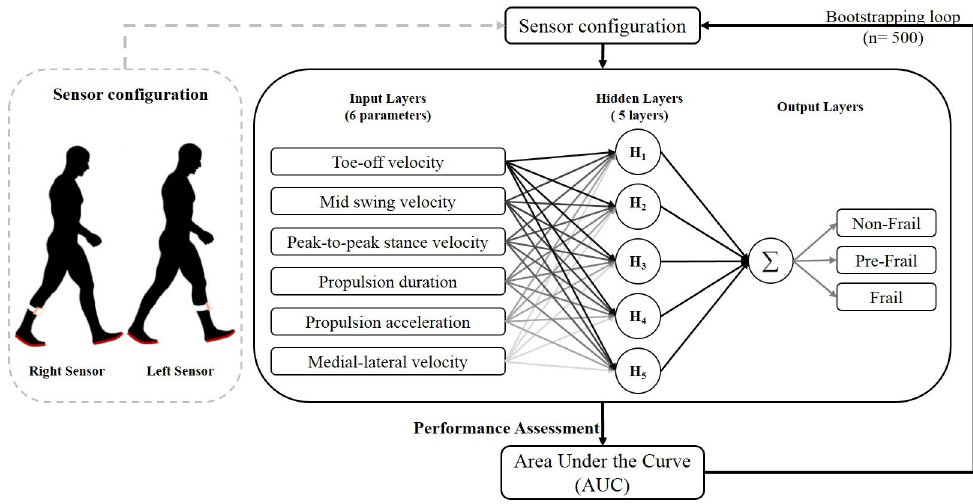
Figure 2. An eight-fold cross validation model with five hidden layers Artificial Neural Network was constructed to test the reliability and accuracy of classifying the frailty status of the participants in the study. Six selected gait parameters were identified and used as inputs to the model. The performance of the model was evaluated using the area under the curve. A 95% confidence interval was calculated to assess the reliability of the